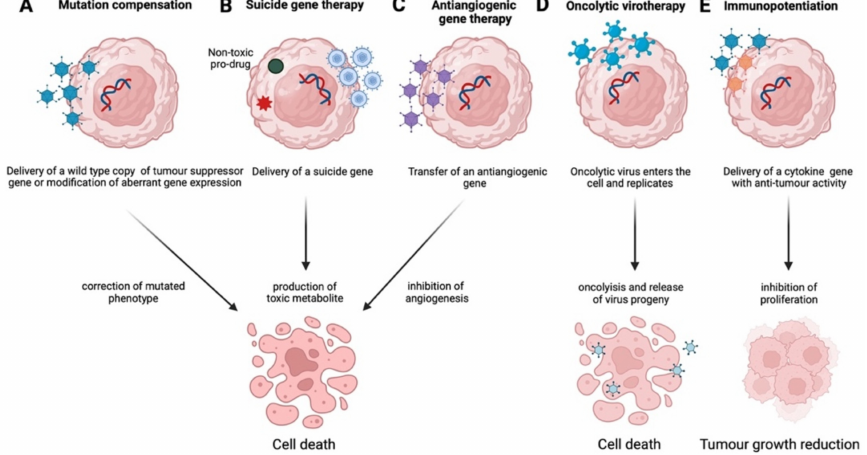
Figure 2. Main targeted approaches for the gene therapy of gynaecological malignant and benign disorders. They mainly involve ( A ) Mutation compensation employing primarily adenoviral vectors to correct the mutated phenotype or modify aberrant gene expression in tumour cells, usually leading to cancer cell death ( B ) Suicide gene therapy, usually with the delivery of a suicide gene, such as HSV-TK , leading to cell death following the production of toxic metabolite ( C ) Antiangiogenic gene therapy, by transferring an antiangiogenic gene, which inhibits cancer cell angiogenesis resulting in cancer cell death ( D ) Oncolytic virotherapy using oncolytic viruses that enter the cell, replicate and lead to oncolysis and cancer cell death. ( E ) Immunopotentiation by delivering a potent anti-cancer cytokine gene within the tumour using primarily adenoviruses and adeno-associated viral vectors, leading to reduction in tumour